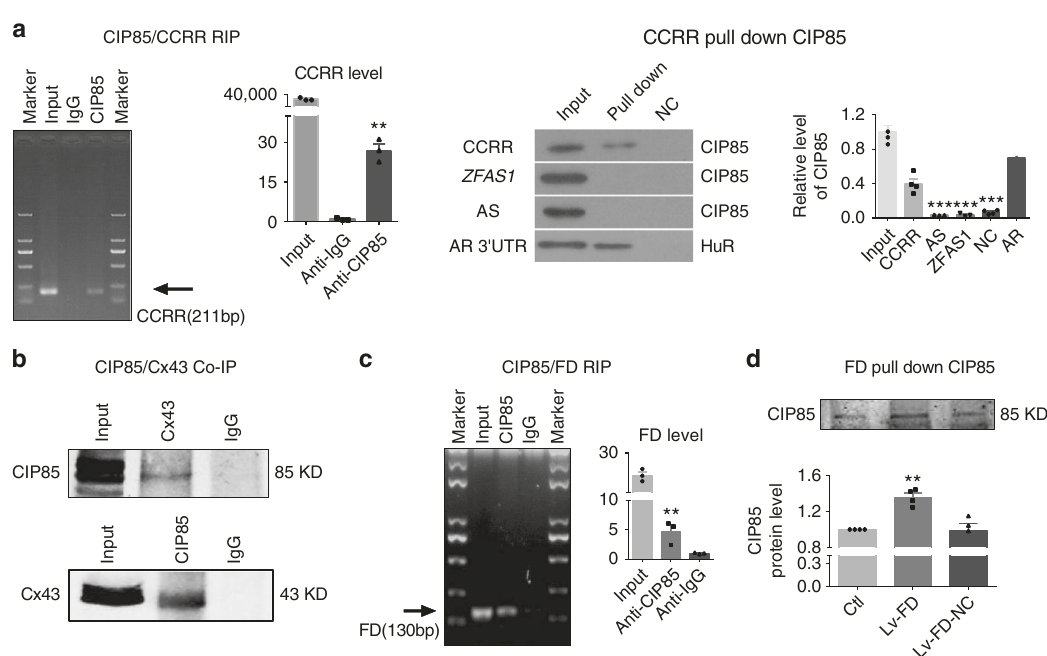
Fig. 7 Interactions between CCRR and CIP85 and between CIP85 and CX43. a RNA immunoprecipitation (RIP) showing the physical interaction between CCRR and CIP85 proteins in cultured neonatal mouse ventricular myocytes (NMVMs). Most left panel: the electrophoresis gel image showing the anticipated fragment representing CCRR that was pulled down by CIP85 antibody with IgG antibody as a negative control. Middle left panel: the quanti fi ed results of the electrophoretic bands. ** P < 0.01 anti-CIP85 vs. anti-IgG; n = 4 batches of cells for each group. Middle right panel: an example of immunoblotting bands showing the pulldown of CIP85 protein by CCRR or other RNAs as labeled on the left. ZFAS1 : an lncRNA used as a negative control; AS: antisense to CCRR used as another negative control; AR: androgen receptor 3 ′ UTR: a commercially obtained positive control; Input: puri fi ed CIP85 as a positive control; NC: negative control probe; HuR: Hu-antigen R. Right panel: mean relative band densities representing CIP85 protein with varying treatments. *** P < 0.001 AS, ZFAS1 , NC vs. CCRR; n = 4. b Protein co-immunoprecipitation (Co-IP) con fi rming the physical interaction between CIP85 and Cx43 in cultured NMVMs. Upper panel shows the presence of CIP85 in an anti-Cx43 pulldown sample, and lower panel shows the presence of Cx43 in an anti-CIP85 pulldown sample. c RIP results showing the physical interaction between FD and CIP85 proteins in heathy mice. Right panel: the quanti fi ed results of the electrophoretic bands. ** P < 0.01 anti-CIP85 vs. anti-IgG; n = 3 mice for each group. d Immunoblotting image showing the pulldown of CIP85 protein by FD. Sham: non-treated sample; Lv-FD: lentiviral vector carrying FD. Lv-FD-NC: lentiviral vector carrying negative sequence. Lower panel: mean relative band densities representing CIP85 protein with varying treatments. ** P < 0.01 Lv-FD vs. Lv-FD-NC; n = 4. (Mean ± SEM; ANOVA followed by Dunnett ’ s test for multiple group comparisons, and Student t test for two group